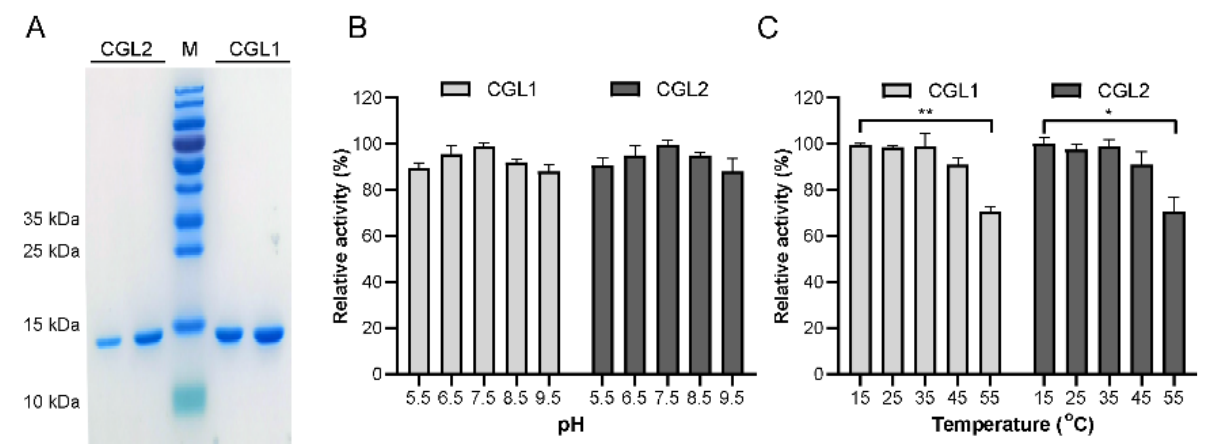
Figure 1. Purification of CGL1 and CGL2 and effects of pHs and temperatures on their stability. ( A ), Coomassie brilliant blue R250 stained 15% SDS ‐ PAGE gel showed molecular weights of about 16 kDa for CGL1 and CGL2. ( B ), pH stability at pH 5.5–9.5. Samples were incubated at 4 °C for 24 h. ( C ), Thermostability at 15–55 °C. Samples were incubated at pH 7.0. The data were analyzed using a student’s t ‐ test (* p < 0.05, ** p < 0.01). Data show mean ± SD, n = 3.